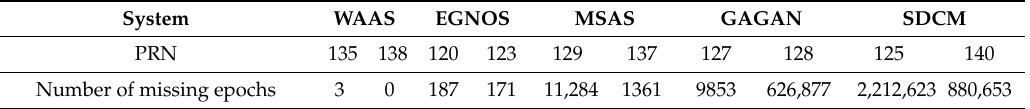
Table 1. The number of missing epochs for each satellite-based augmentation system (SBAS) satellite. System WAAS